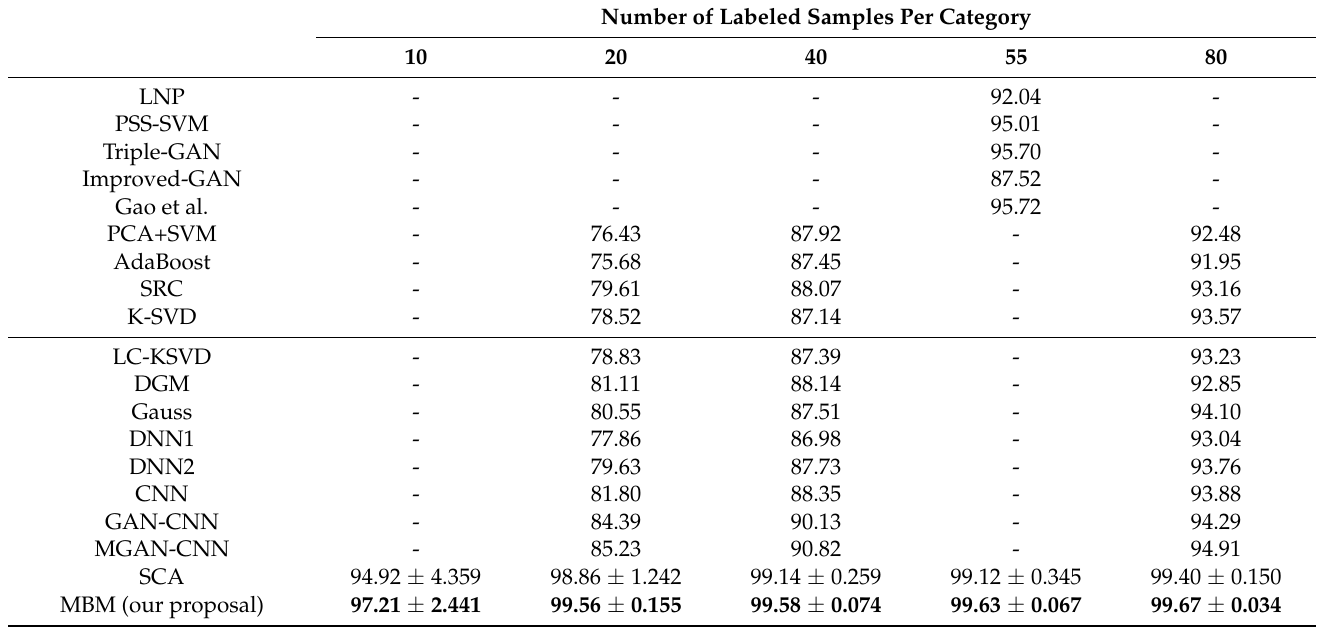
Table 4. Recognition accuracies of the proposed semi-supervised learning method and other semi-supervised methods under different amounts of labeled samples per category on the MSTAR data set. The bold numbers represent the optimal value in each column. Hyphens indicate that accuracy is not present in the published article.